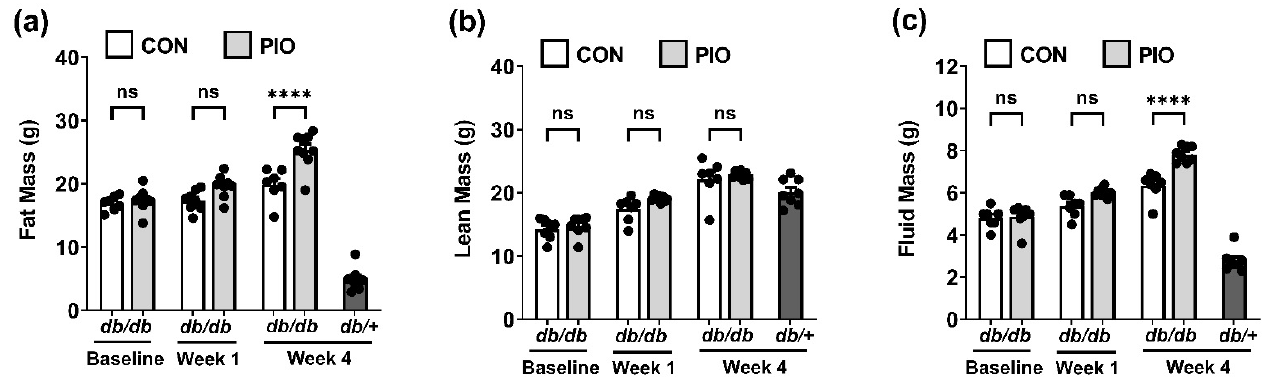
Figure 2. Four week dietary supplementation of PIO increases fat and fluid mass in db/db mice. ( a ) Fat mass, ( b ) lean mass, and ( c ) fluid mass in db/+ mice on a control diet, and db/db mice on either a CON or PIO-supplemented diet for 28 d. n = 8 per group. Data are represented as the means ± SEM. **** p < 0.0001. ns, not significant.